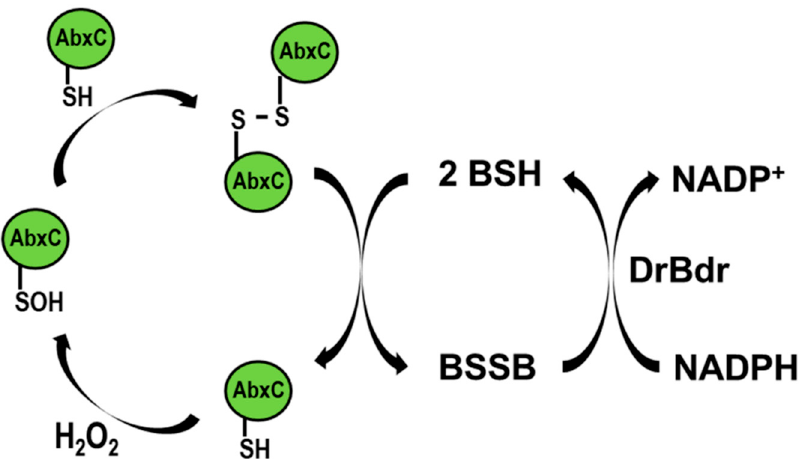
Figure 8. The possible recycling pathway of AbxC. Under H 2 O 2 stress, oxidation of the AbxC thiol (AbxC-SH) leads to the formation of a sulfenic acid intermediate of AbxC (AbxC-SOH), which can react with another AbxC-SH to form an intermolecular disulfide bond. BSH functions in reduction of the AbxC dimer to release the active AbxC monomer, resulting in BSSB formation. The BSSB reductase DrBdr regenerates BSH on expense of NADPH.